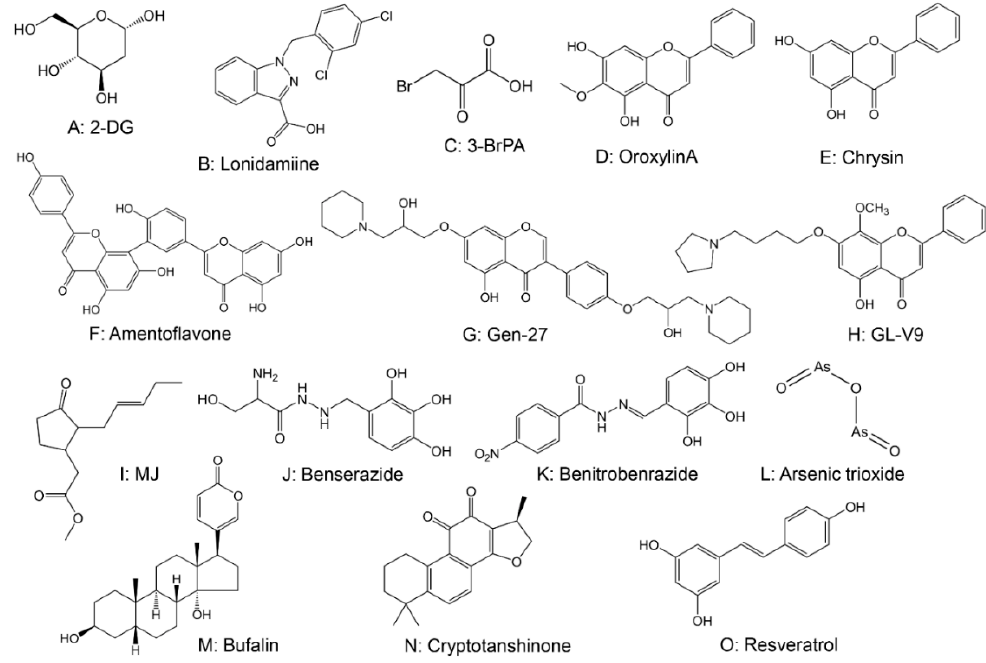
Figure 4. The chemical structures of drugs targeting hexokinase.